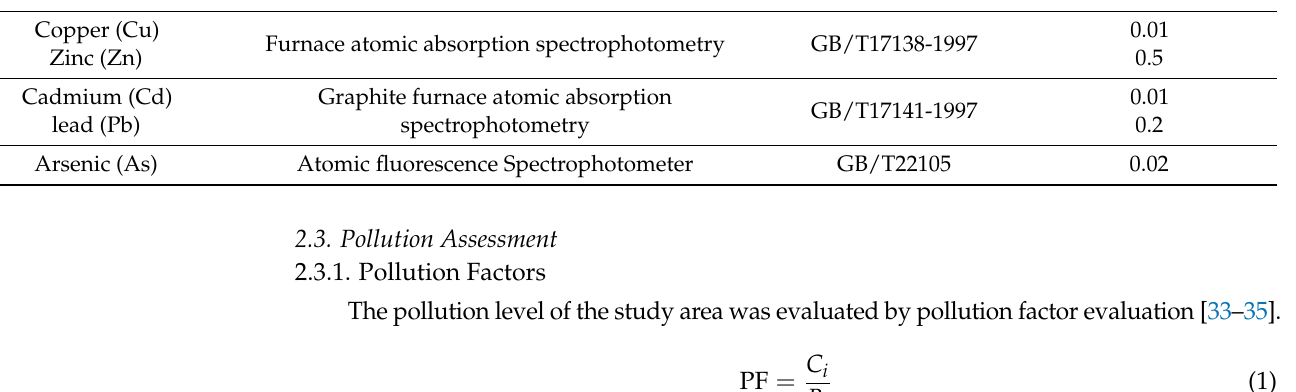
Table 1. Detection methods.